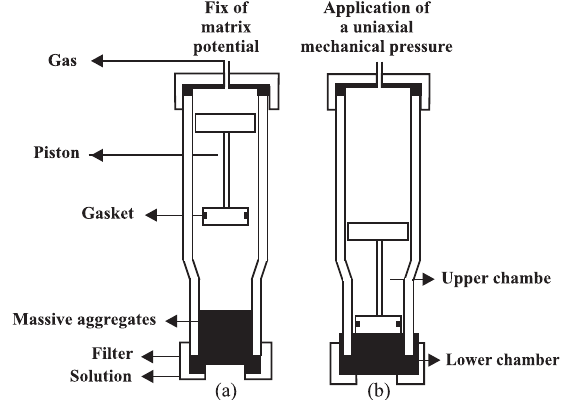
Figure 1. Mechanism used for this work: (a) fixation matrix potential (Tessier & Berrier, 1979) e (b) application of a uniaxial mechanical pressure (Sala & Tessier (1993), Apud Tavares Filho et al.